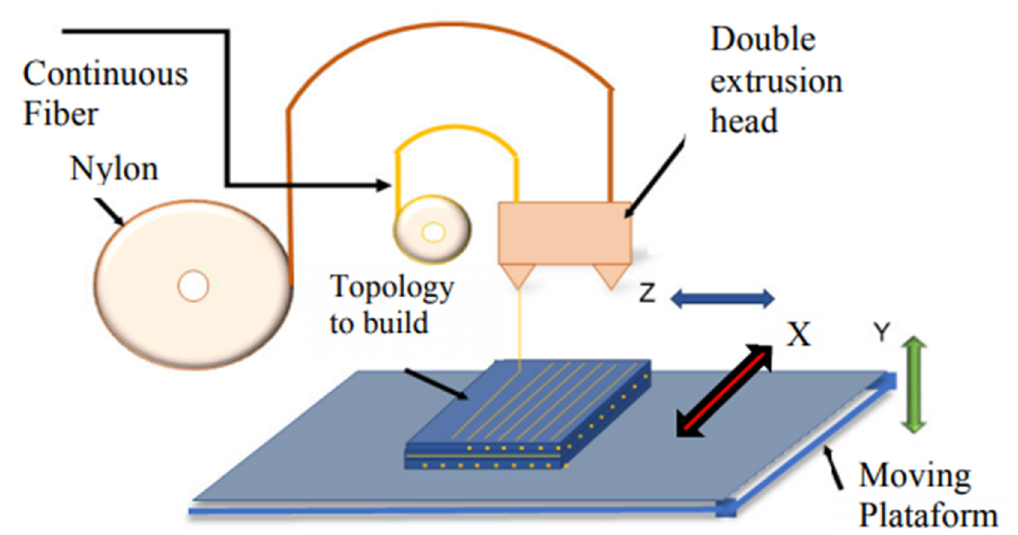
Figure 1. Schematic of the 3D printing process on the Markforged Two printer. Adapted from [2].